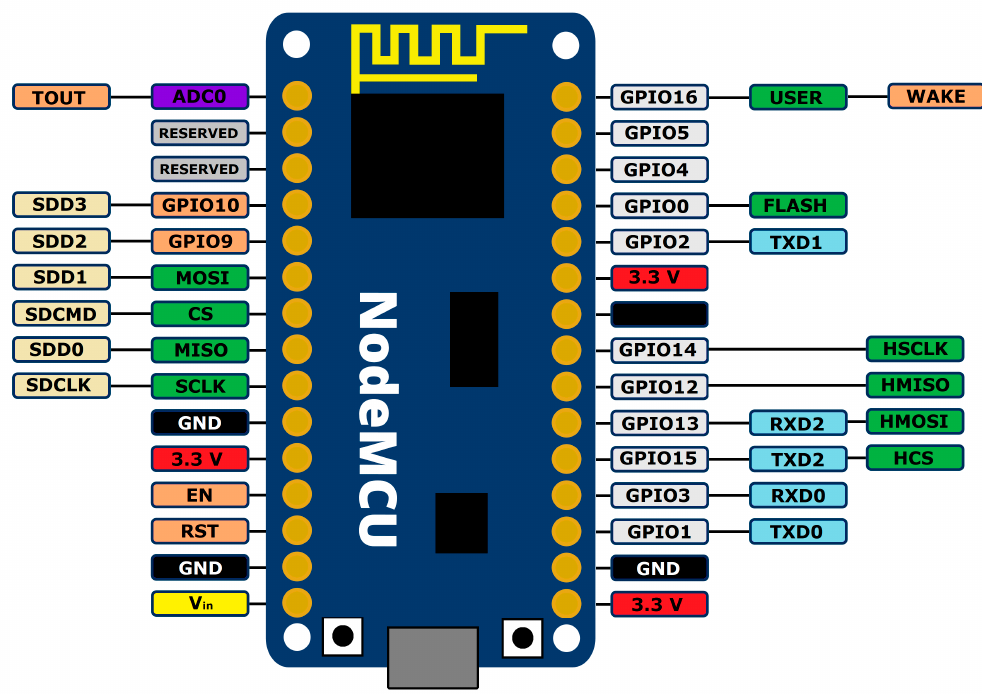
Figure 1. NodeMCU